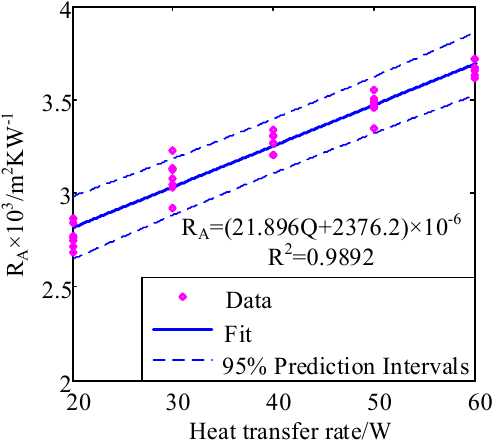
Figure 8. Fitting curve of the areal thermal resistance and corresponding 95% confidence interval.